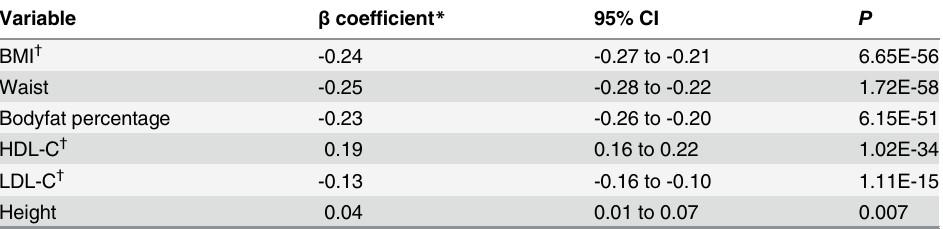
Table 2. Results from multiple linear regression models adjusted for sex and age examining correla- tions between fasting values of growth hormone and traditionally associated